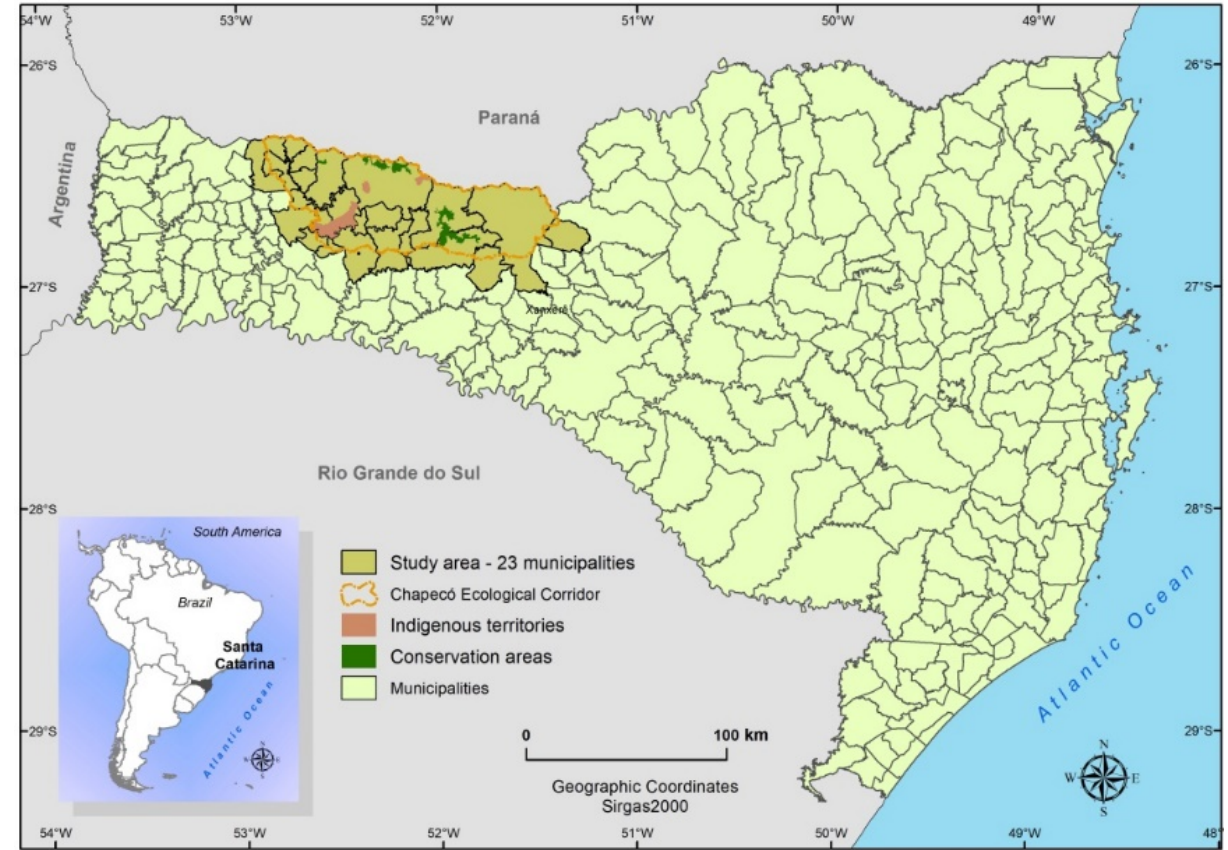
Figure 1. Location of the study area.